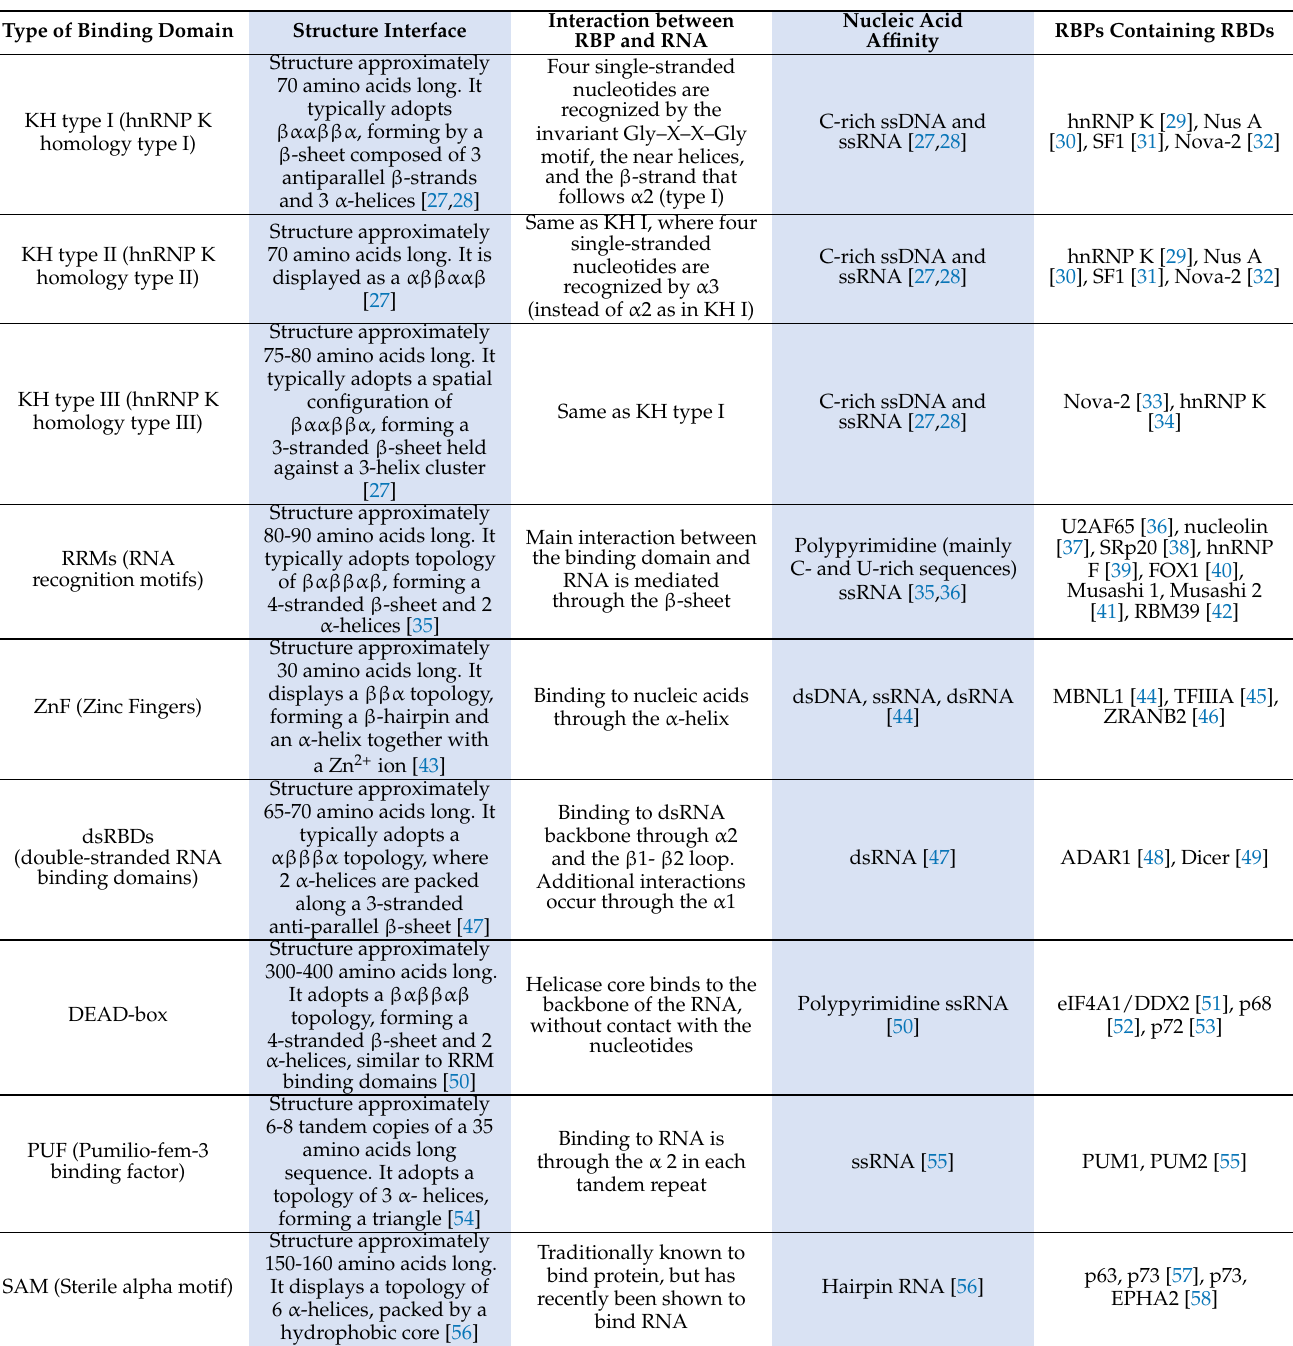
Table 1. RNA-binding domains